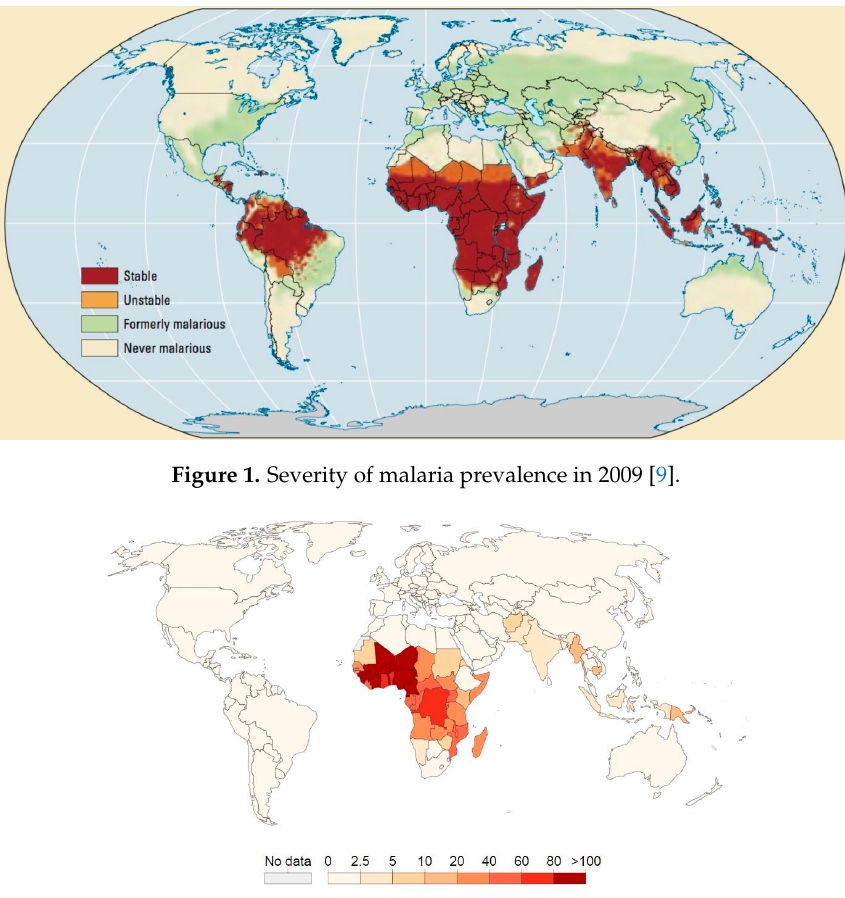
Figure 2. Malaria death rates per 100,000